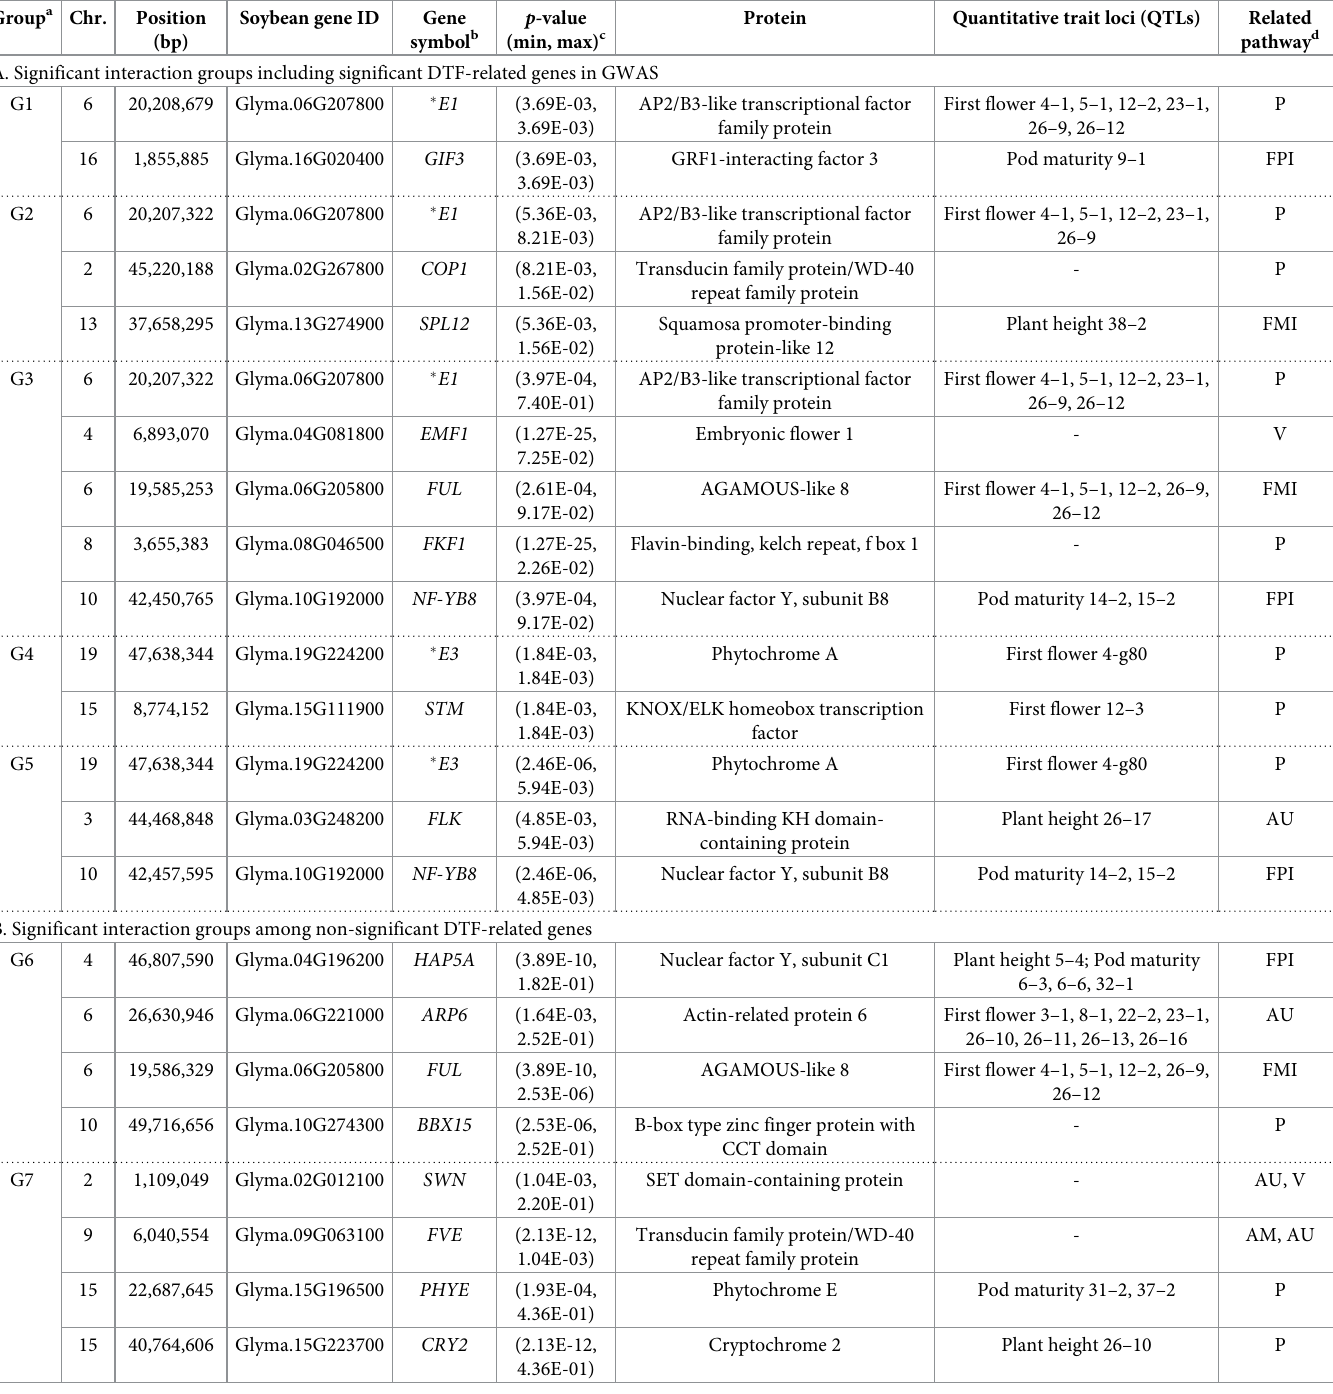
Table 2. Multilocus epistatic interactions among 5,534 SNP markers related to DTF. Group a